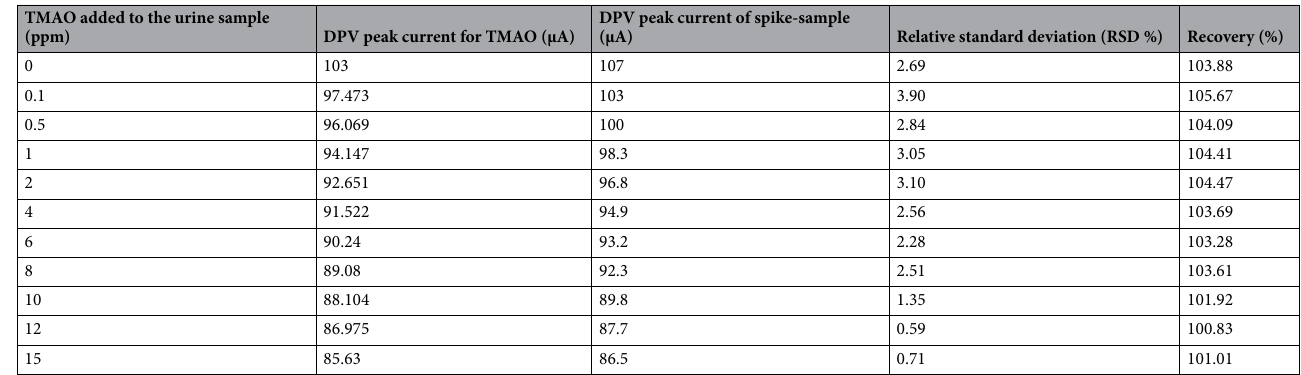
Table 5. Relative standard deviation (RSD) and recovery percentage of TMAO from human urine samples using MIP/ITO electrode.